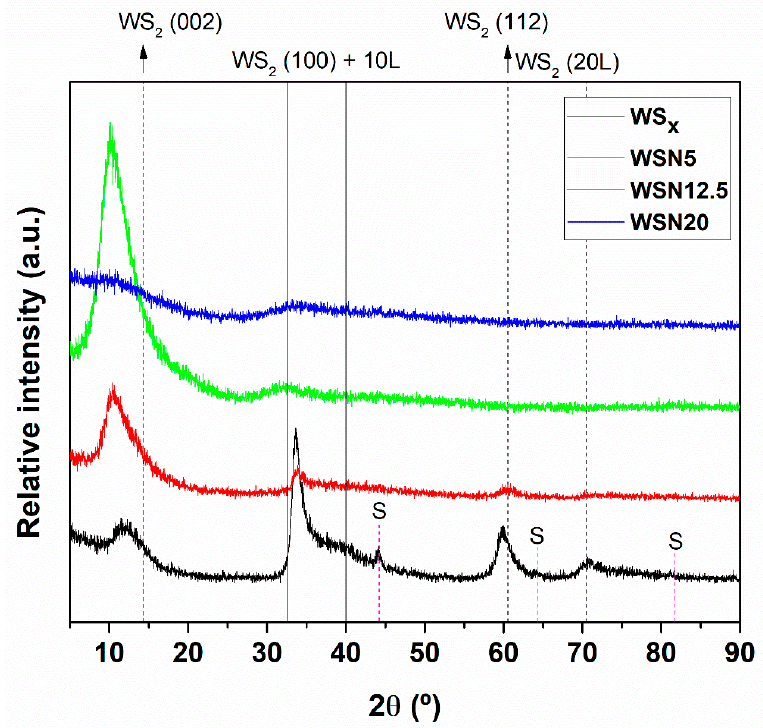
Figure 2. X-ray diffraction patterns of the as-deposited coatings (WS 2 ICCD card: 087-2417).